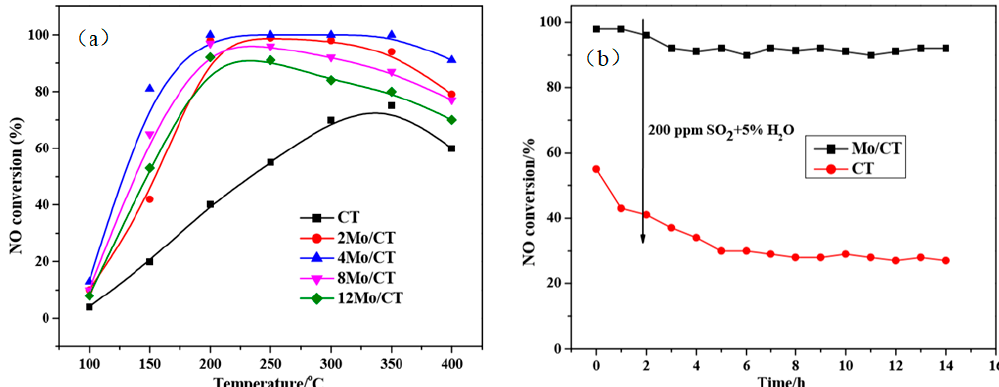
Figure 15. ( a ) NO conversions on these MoO 3 /CeO 2 –TiO 2 (Mo/CT) catalysts with different Mo and ( b ) H 2 O + SO 2 resistance of the CeO 2 –TiO 2 (CT) and Mo/CT catalysts at 250 °C [96].